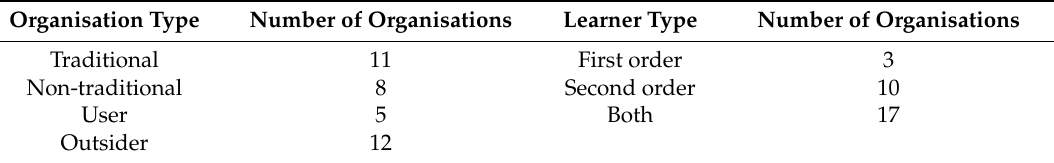
Table 4. Different organisation and learner types in the rainwater harvesting network interaction